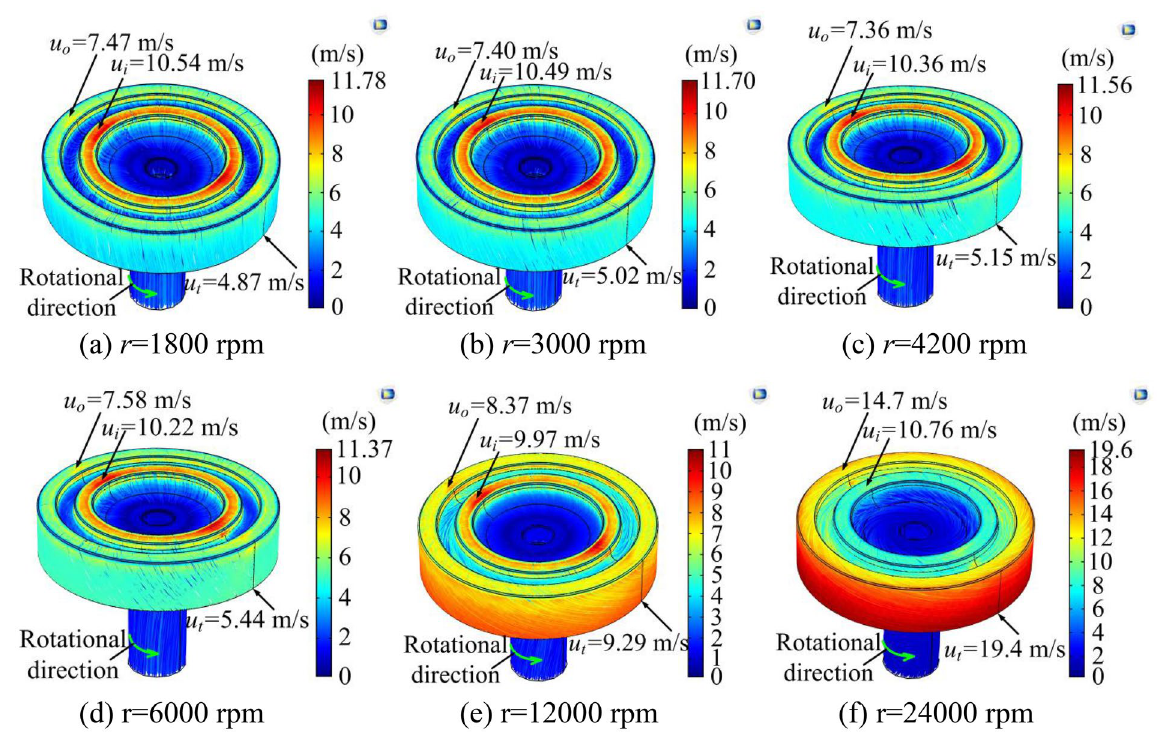
Figure 3. Electrolyte streamline at different rotation